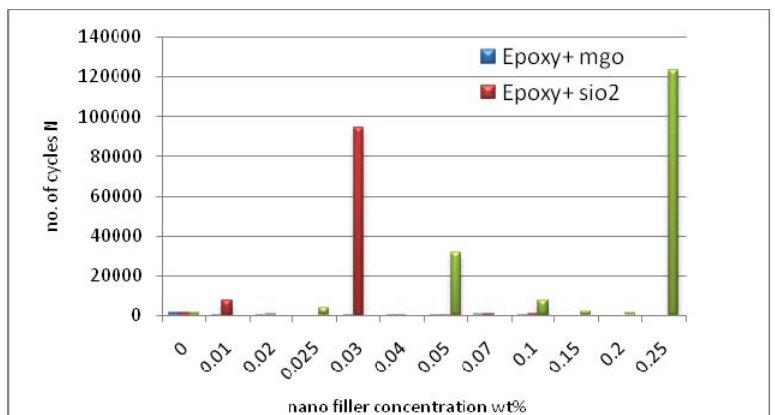
Fig. 5: The behavior of no. of cycles with nano filler concentration.